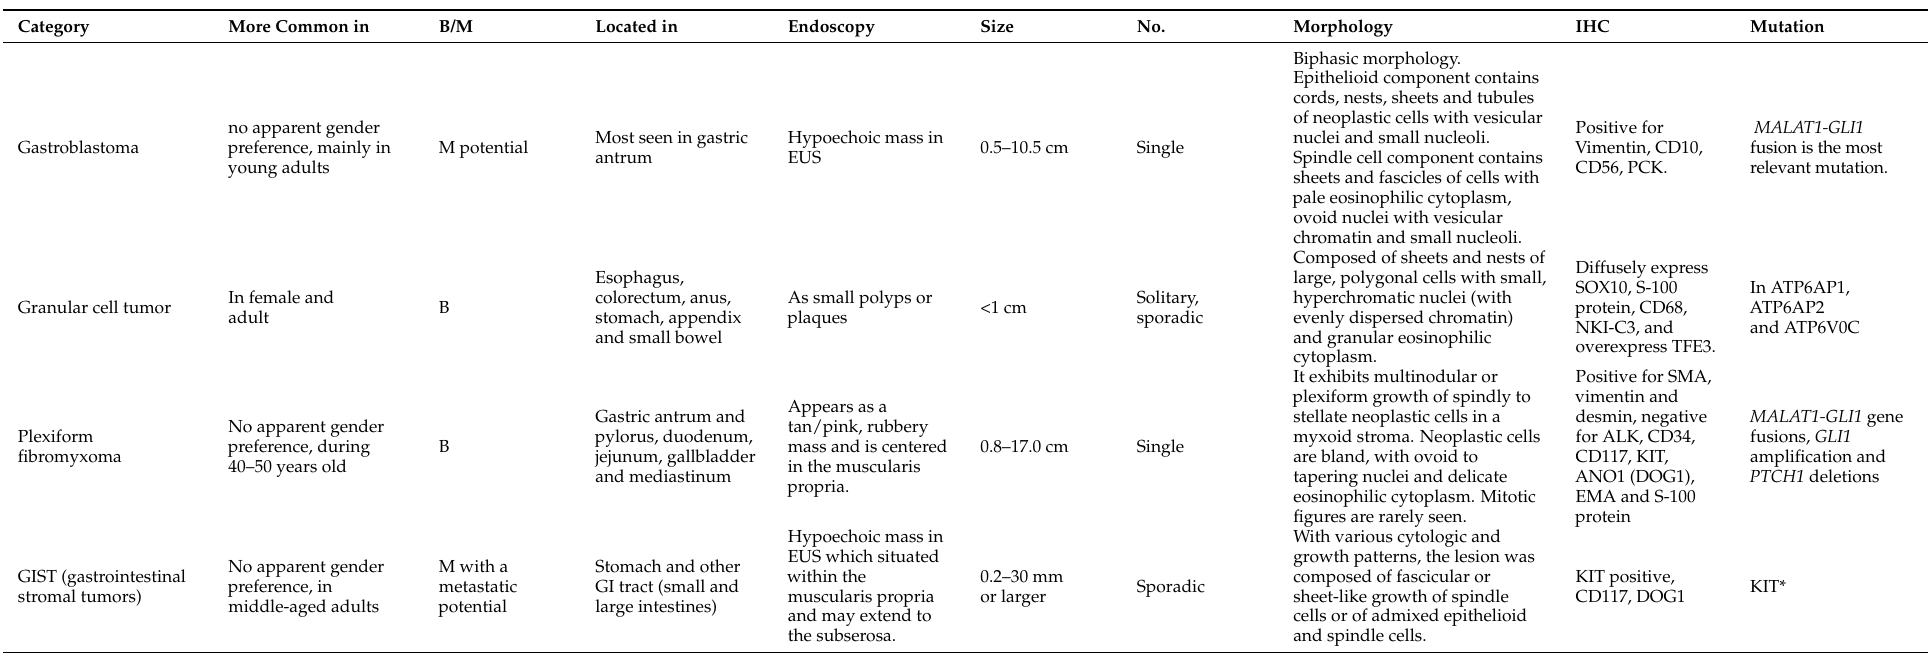
Table 4. Differential